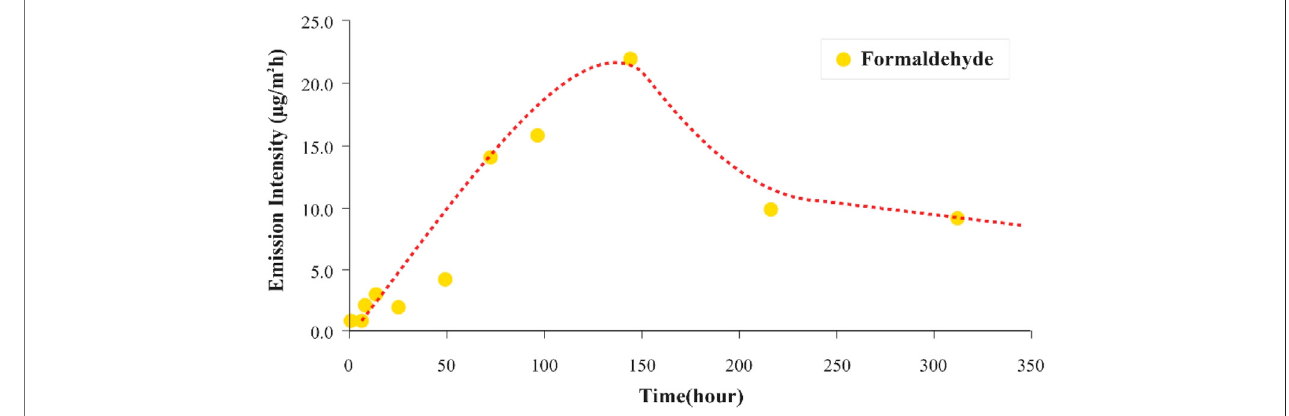
FIGURE 6 | Emission pattern of CH 2 O from wallpaper.